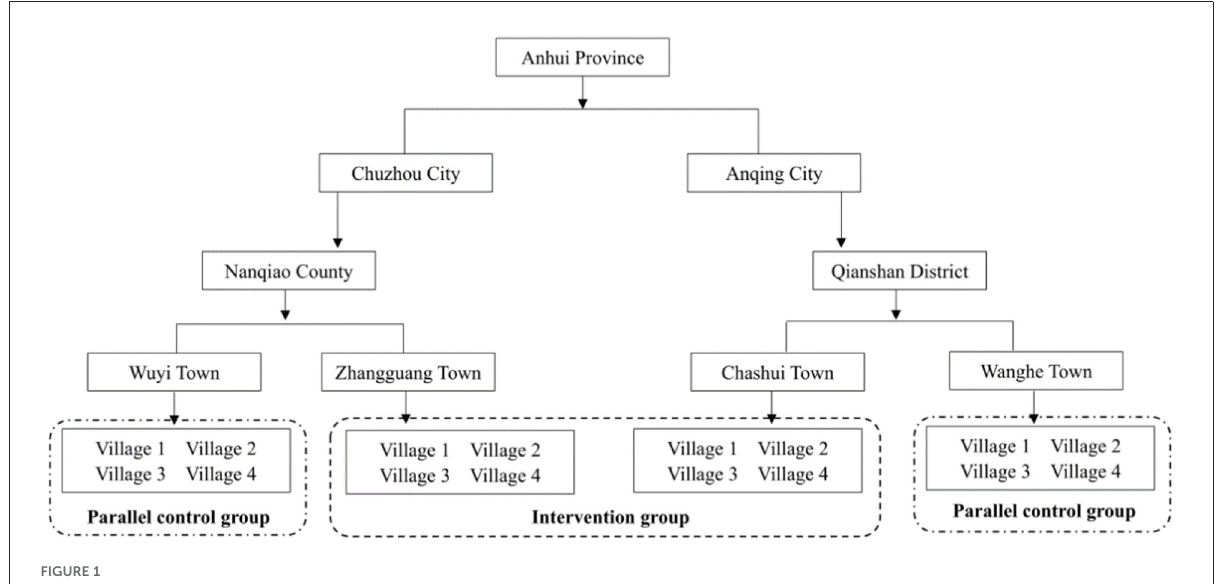
FIGURE1 Intervention diagram of this